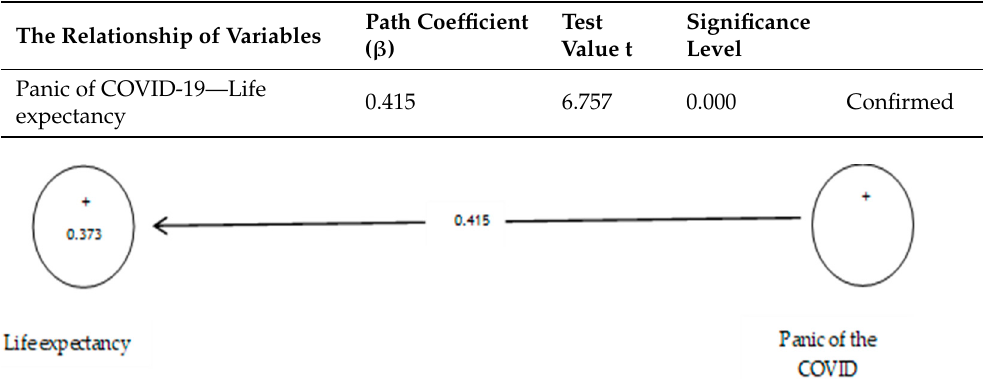
Figure 16. The seventh sub-hypothesis model includes factor load coefficients.